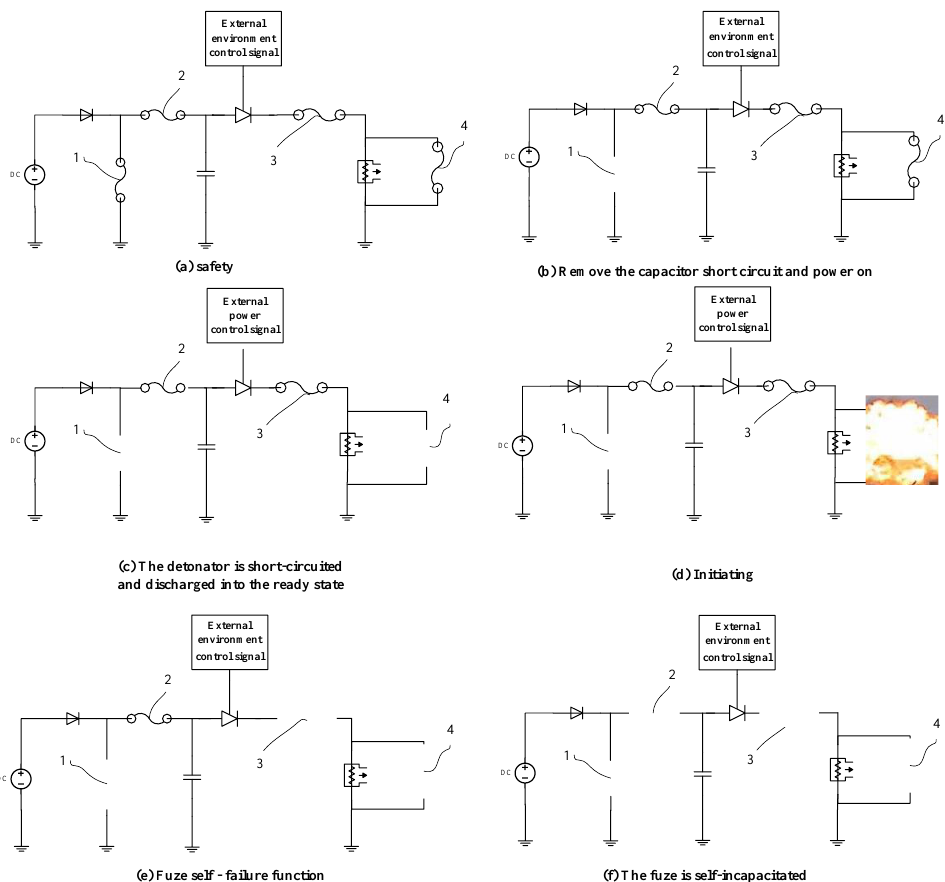
Figure 1. Fuse-logic control-chip deprotection logic and self-failure function.